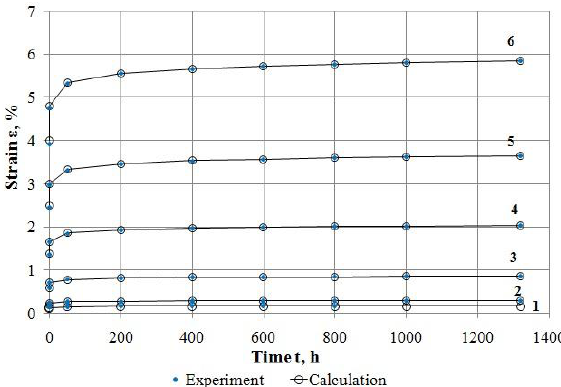
Figure 6. Creep curves of glass-reinforced plastic ( Ѳ = 45°) at various stresses: 1–20.3 MPa, 2–40.6 MPa, 3–60.9 MPa, 4–81.2 MPa, 5–101.5 MPa, 6–121.8